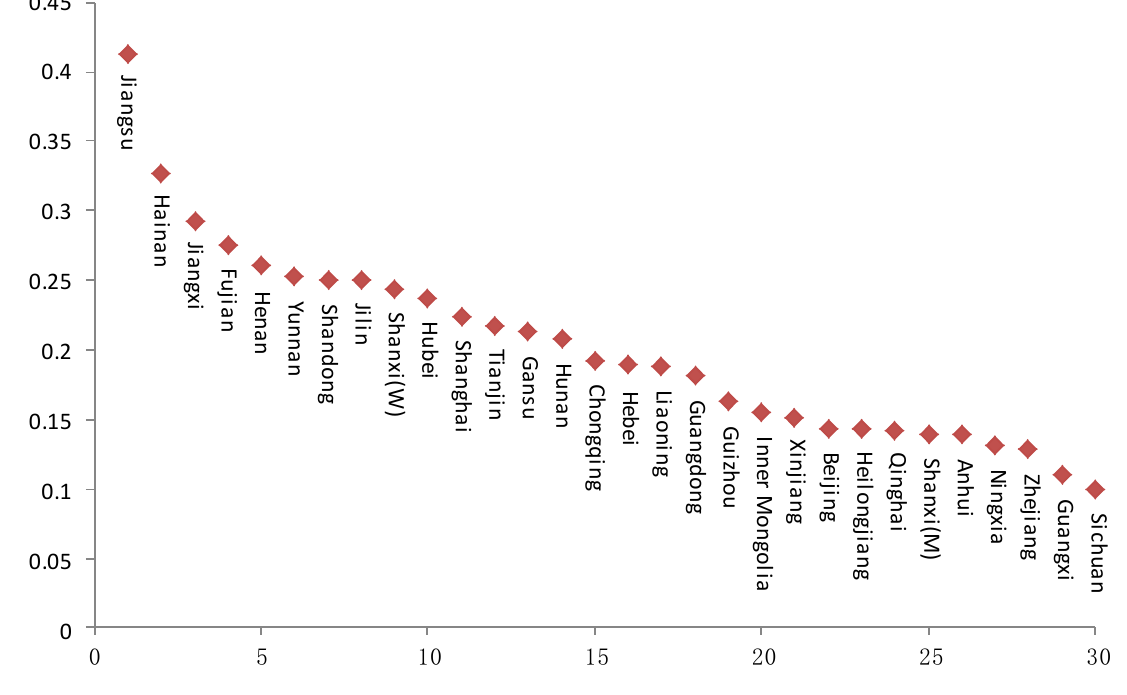
Figure 5. Chinese provincial shadow price of energy in